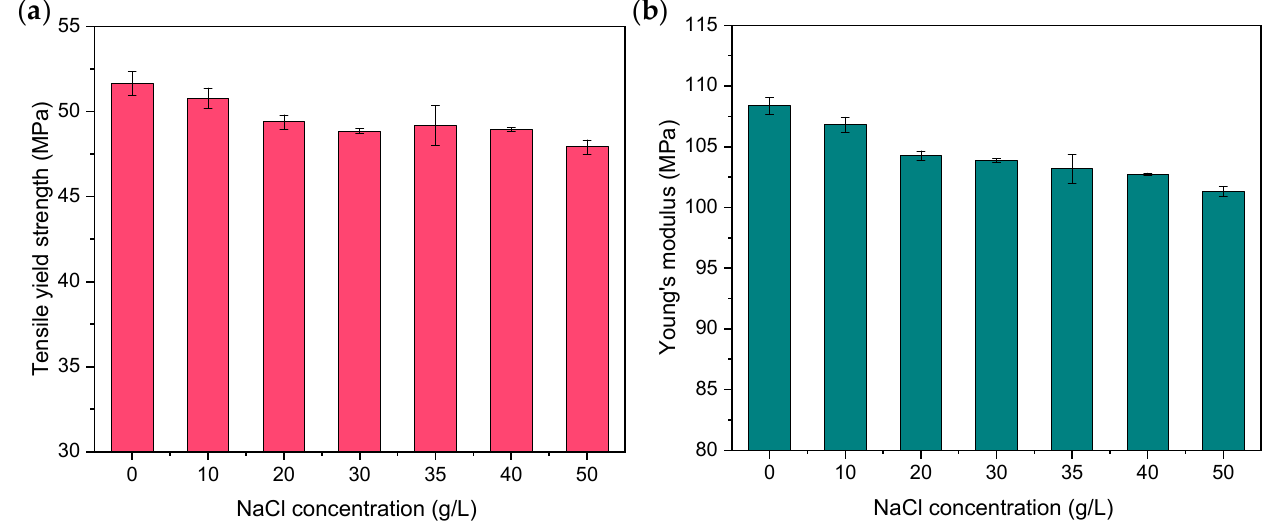
Figure 3. Mechanical properties of the membrane after ex situ degradation test with Fenton’s reagent: ( a ) tensile yield strength (MPa) of membranes tested in the presence of different NaCl concentrations; ( b ) Young’s modulus (MPa) of membranes tested in the presence of different NaCl concentrations.